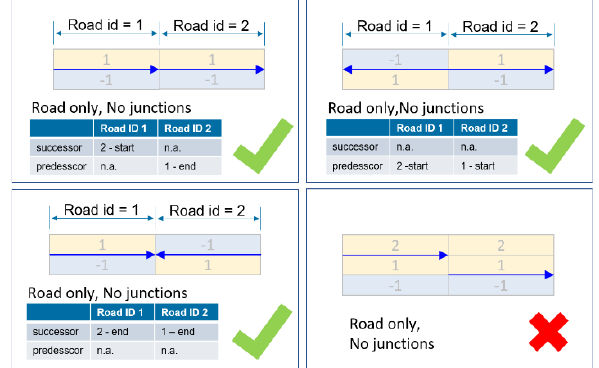
Figure 1. Road linkage in the OpenDRIVE standard (ASAM e.V., 2022)